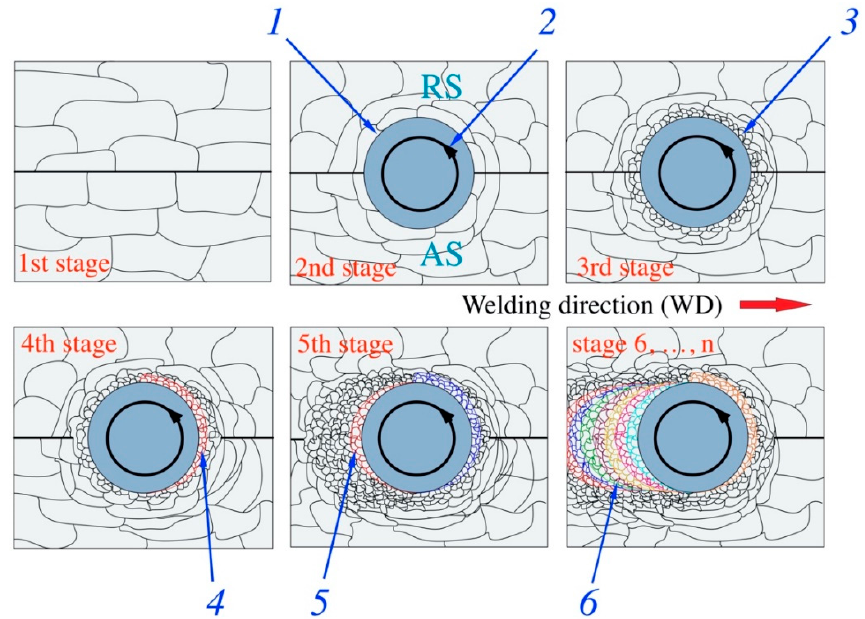
Figure 16. Schematic diagram to illustrate the adhesion-assisted transfer of metal with the FSW pin. 1—tool, 2—rotation direction, 3—primary grain subdivision, 4—formation of transfer layer, 5—reverse transfer (deposition), 6—successive layer-by-layer metal transfer and deposition.